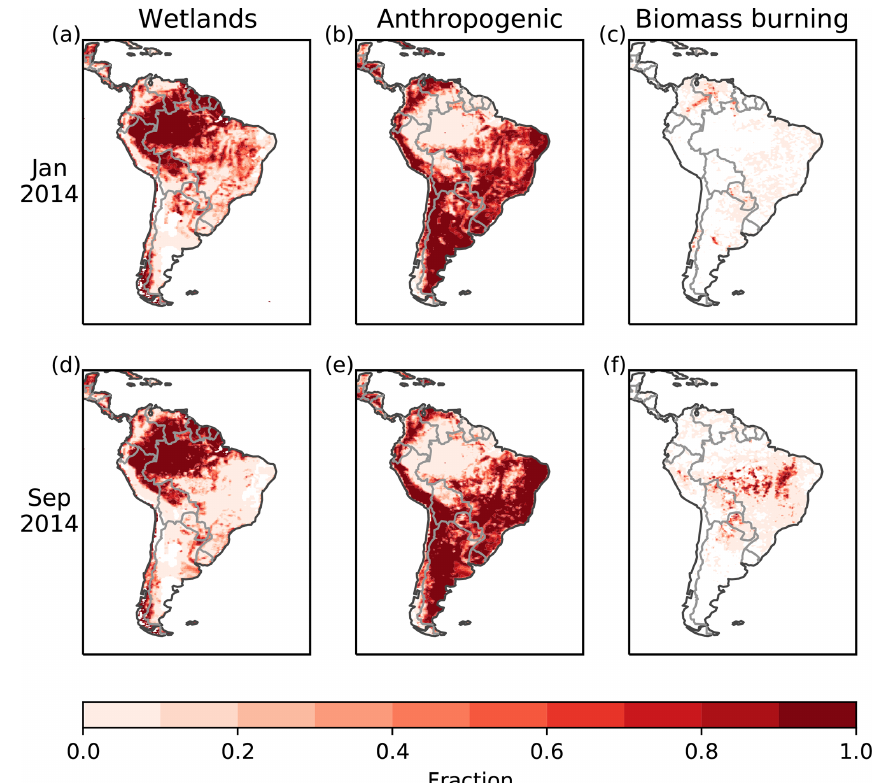
Figure 3. Fraction of wetland, anthropogenic and biomass burning emissions for January (a–c) and September (d–f) 2014 derived from the a priori emissions. Note that the EDGAR anthropogenic inventory is annual resolution and is shown here for